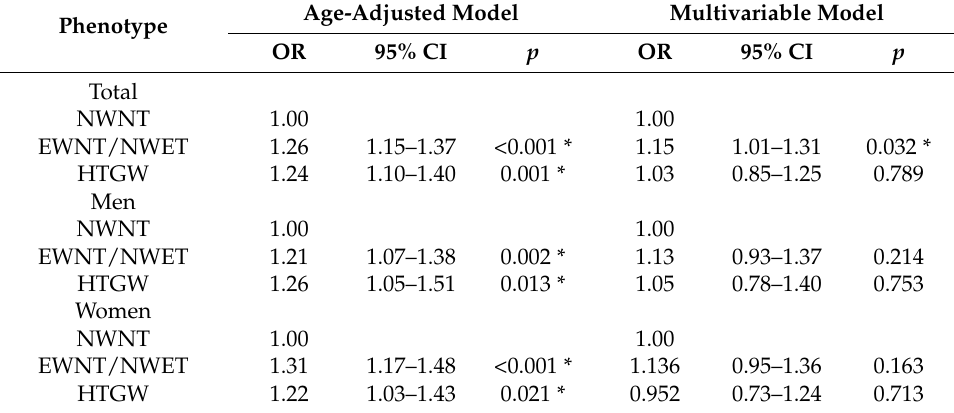
Table 4. Risk of prediabetes according to the three phenotype groups for men and